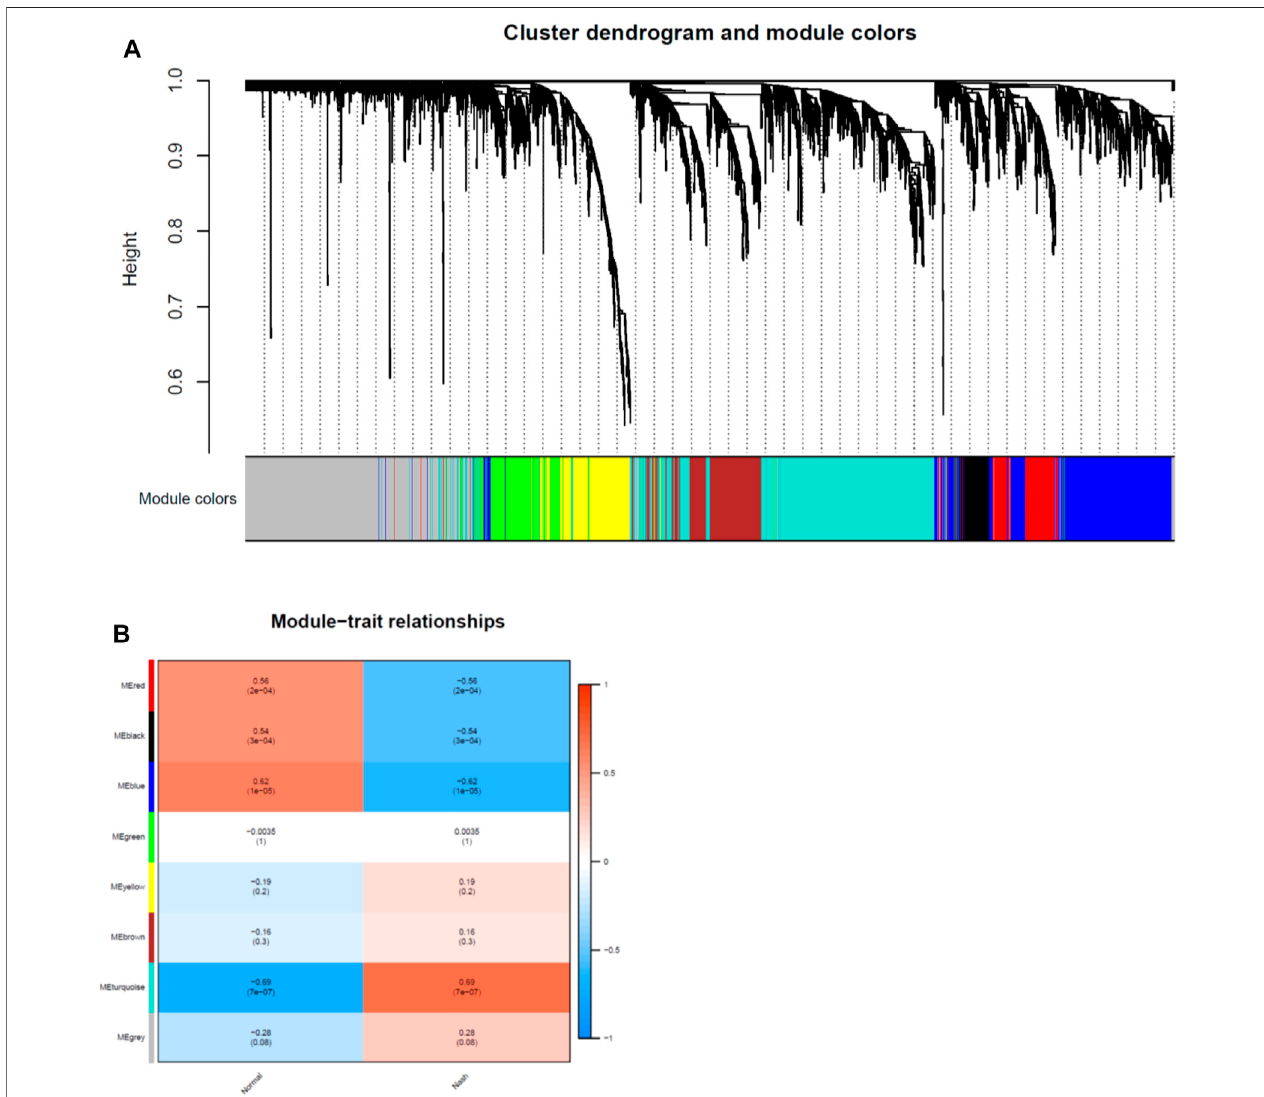
FIGURE 4 | Identi fi cation of modules associated with clinical traits in GSE126848 dataset. (A) The Cluster dendrogram of co-expression network modules was orderedbyahierarchicalclusteringofgenesbasedonthe1-TOMmatrix.Eachmodulewascoloreddifferently. (B) Module-traitrelationships.Eachrowcorrespondstoa module and column corresponds to a clinical trait (NASH or HC). Each cell includes the corresponding correlation and p -value.